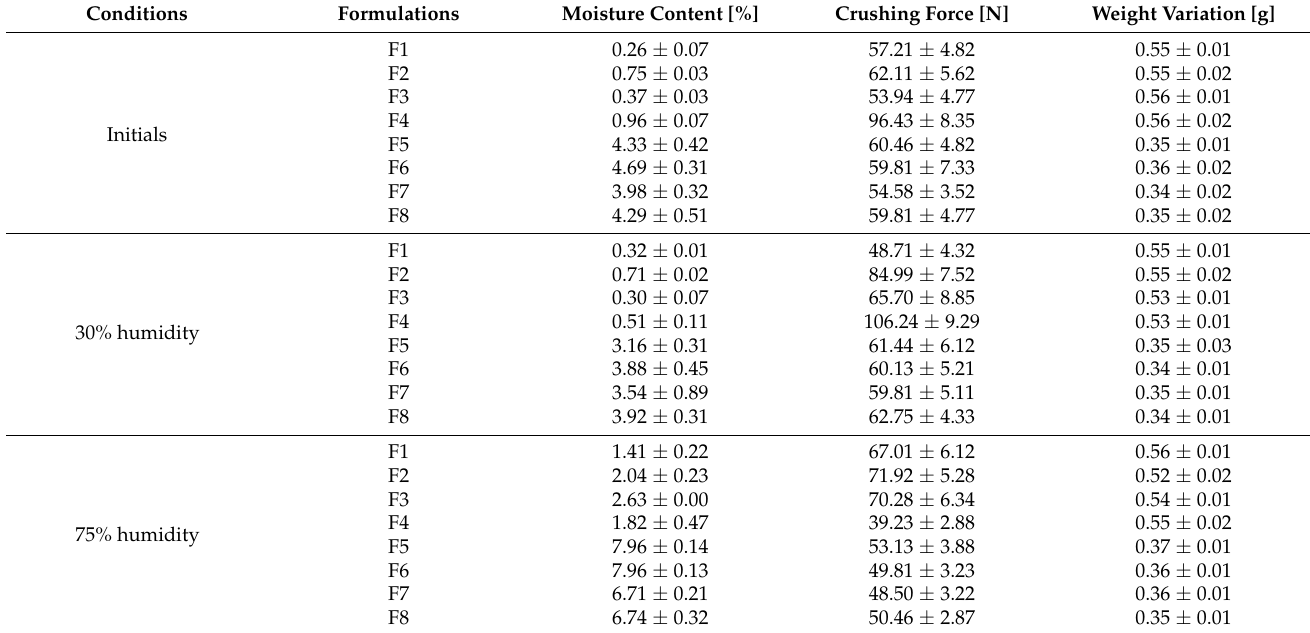
Table 3. Test values for moisture content in placebo (F1–F8) resistance to crushing and weight variation (results are shown as mean value ± standard deviation.